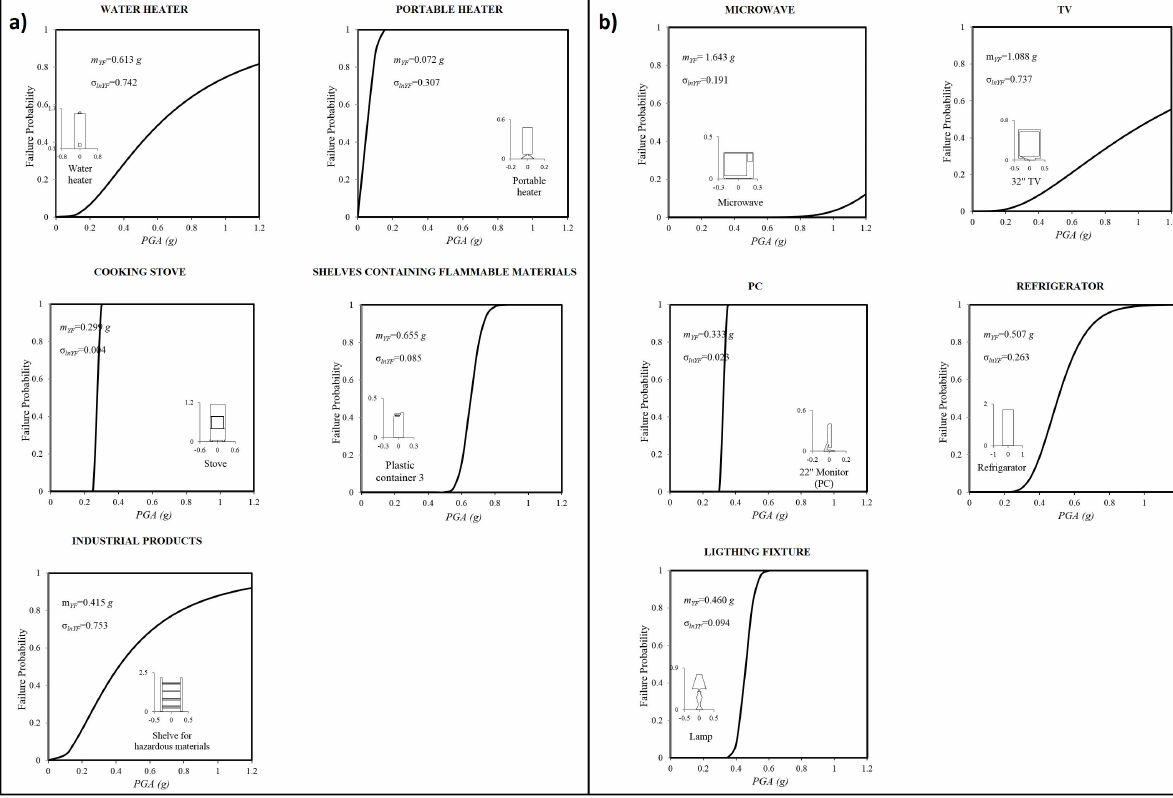
Fig. 3. Overturning probability for (a) hazardous appliances and (b) less hazardous appliances (Reinoso et al., 2010).